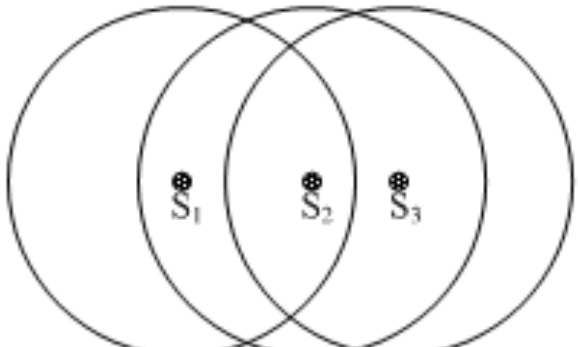
Figure 3. The gradient phenomenon.